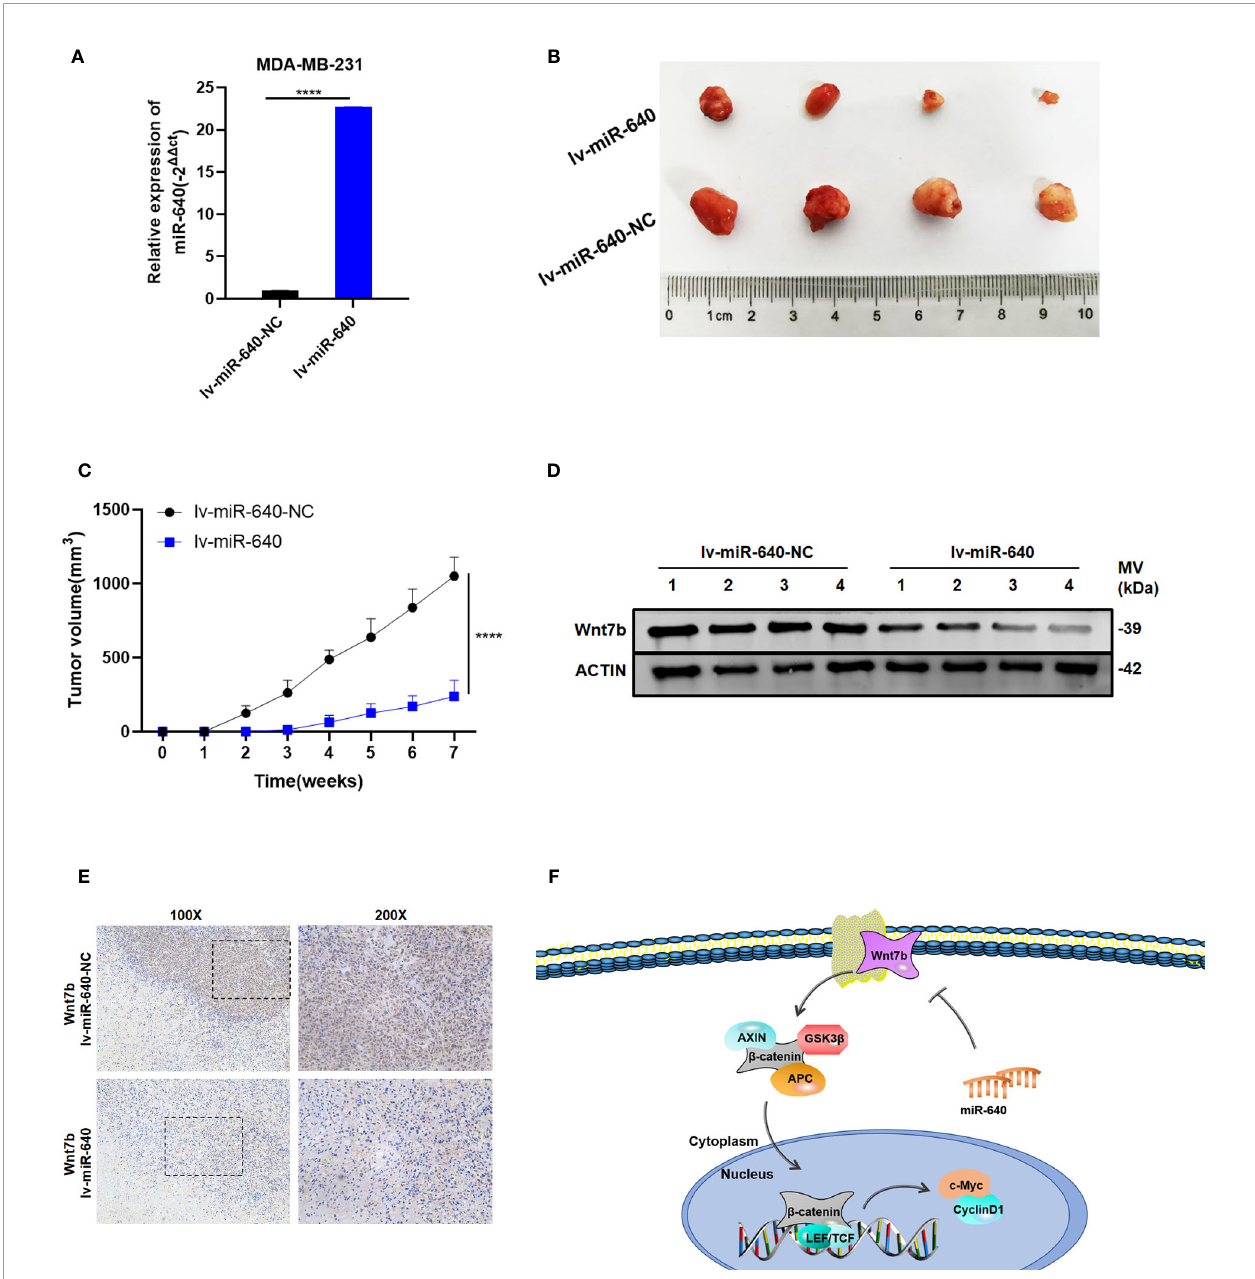
FIGURE 6 | Overexpression of miR-640 inhibited BC growth in vivo . (A) Overexpression of miR-640 in MDA-MB-231 cells was veri fi ed by RT-qPCR. (B) Representative images of xenograft tumors in nude mice. (C) The growth curves of xenografts. (D) Extract protein from tumors and measuring the expression of Wnt7b by Western blotting. (E) Immunohistochemistry (IHC) staining of Wnt7b in xenografts. (F) The mechanism diagram was generated to illustrate the mechanism of miR-640/Wnt7b/Wnt- b -catenin axis in BC. ****p <